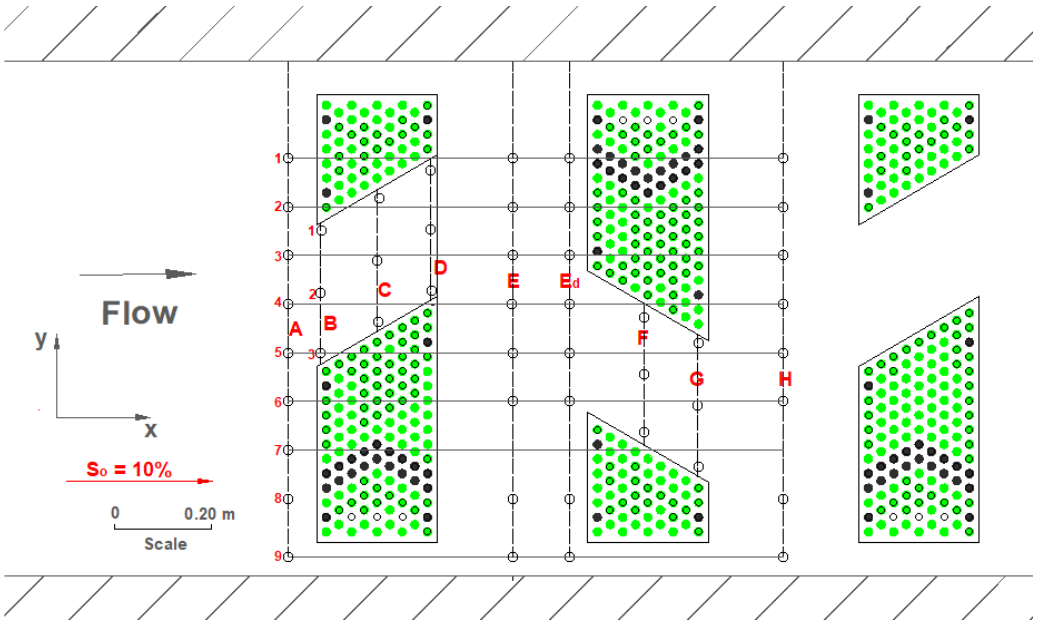
Figure 4. Plan view of the diagonal brush fishway and the ADV velocity measurement points.